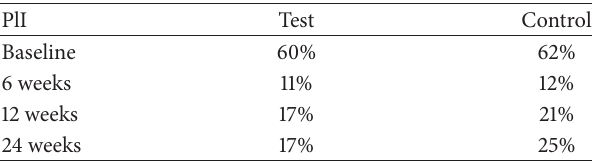
Table 2: Plaque index values in test and control group after 6, 12, and 24 weeks.